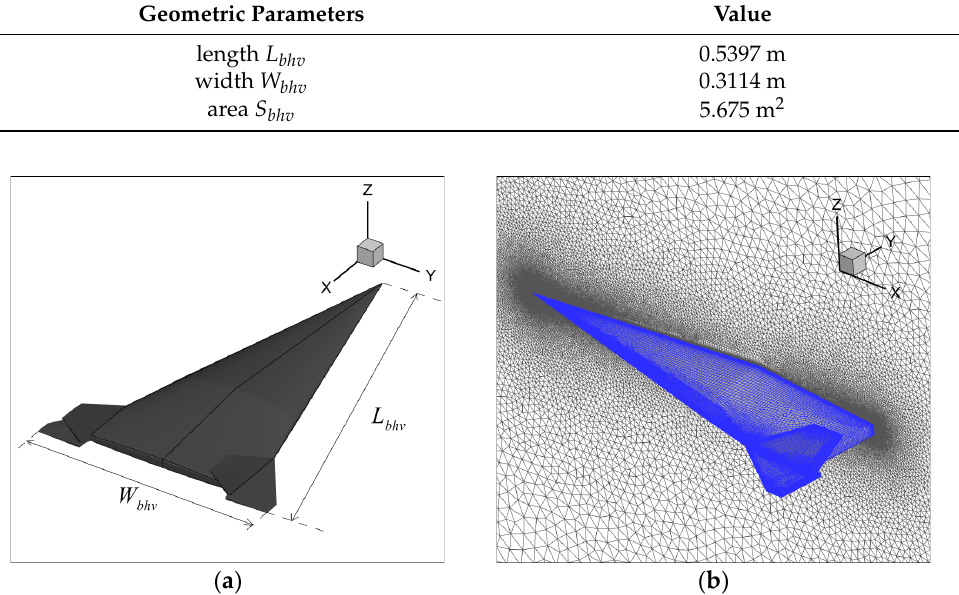
Figure 3. The experimental model and the computational grid. ( a ) BHV model; ( b ) Surface and slice grids.